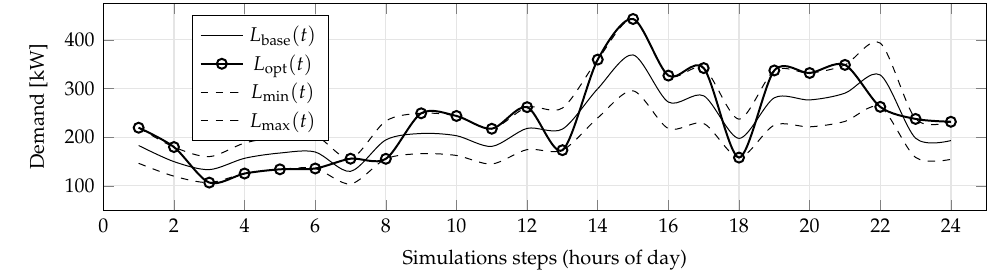
Figure 3. Illustration of the demand flexibility band and the optimized